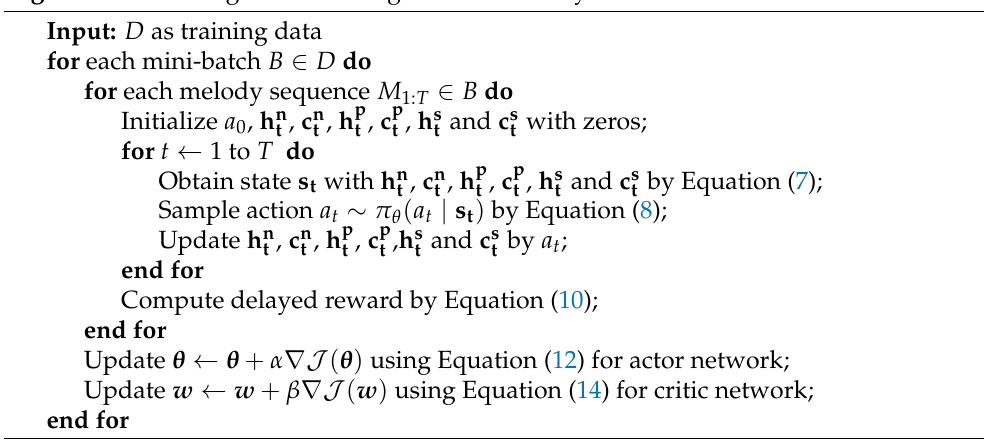
Algorithm 1 Training Process of Segmentation Policy Module with